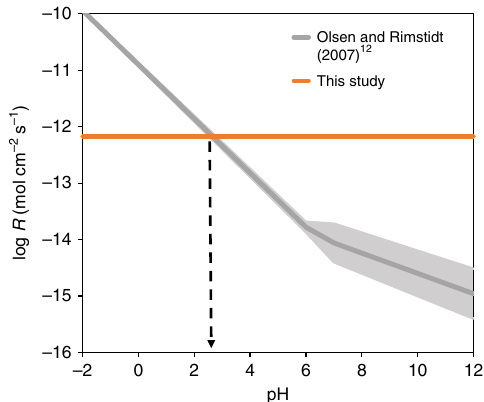
Fig. 3 Relationship of weathering rates of olivine at 25 °C with pH. Weathering rates at − 40 °C calculated in this study are shown by the orange bar. Dark gray lines indicate fi t to the accumulated olivine dissolution data calculated by Olsen and Rimstidt 12 including uncertainties (s.e.m.) (light gray area) and are extrapolated below pH 1. Weathering rates measured in this study are equivalent to the weathering rate of forsterite at 25 °C and a pH of ~2.5